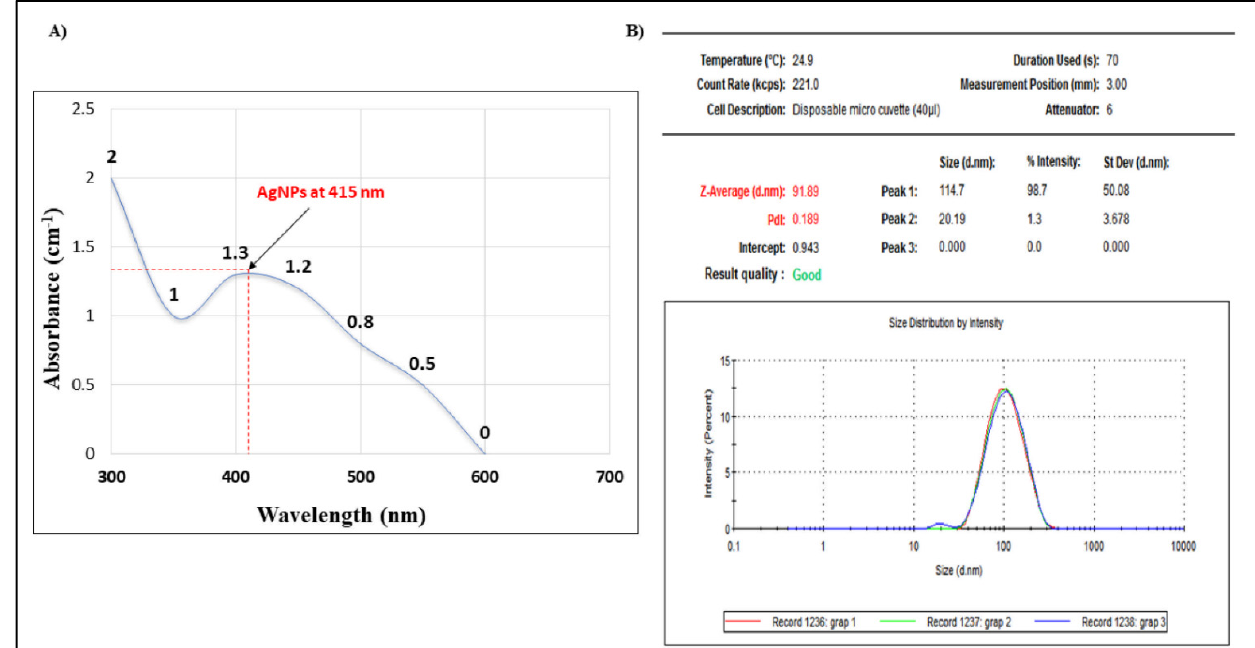
Figure 2. Analysis of the physical properties of GSE-AgNPs. The morphological analysis of the biosynthesised GSE-AgNPs showed their ability to induce higher SPR by UV excitation through either ( A ) UV spectroscopy, or ( B ) the size distribution curve by Zetasizer; three preparations of GSE-AgNPs, at the same concentrations, were used to confirm the results of DLS.